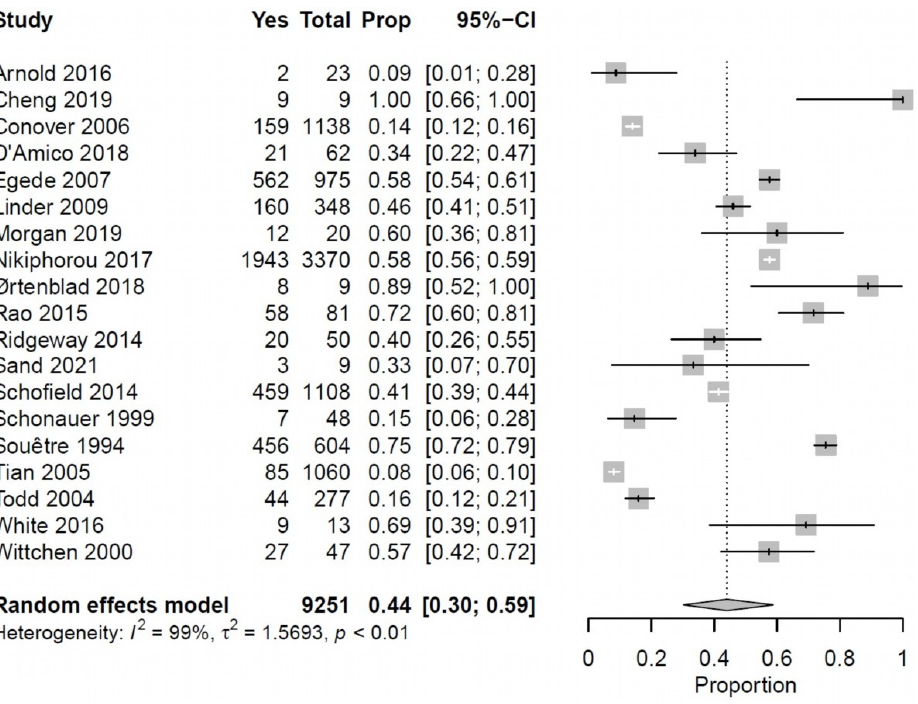
Figure 2. Forest plot shows the percentage of middle-aged persons with multimorbidity and paid employment. When retired populations were identified, they were excluded.